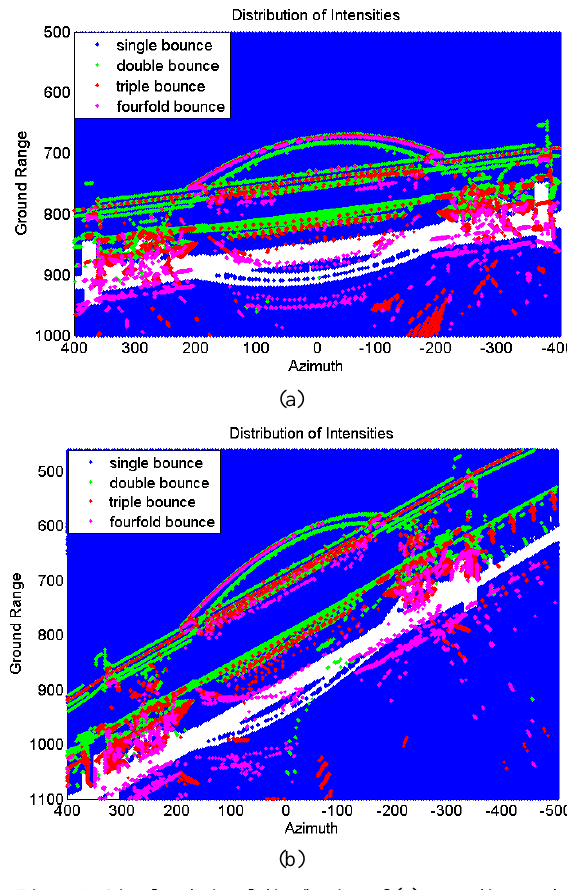
Figure 5. Simulated signal distribution of (a) ascending track (b) descending track. Blue: single bounce. Green: double bounce. Red: triple bounce. Magenta: fourfold